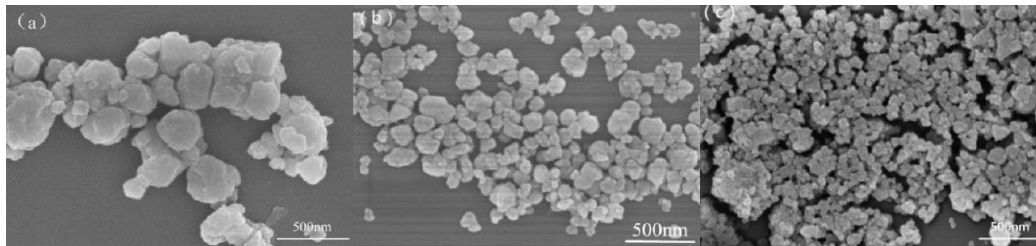
Figure 3. FESEM images of CaMgAl-LDHs ( a ), B-CaMgAl-LDHs ( b ), and O-CaMgAl-LDHs ( c ).